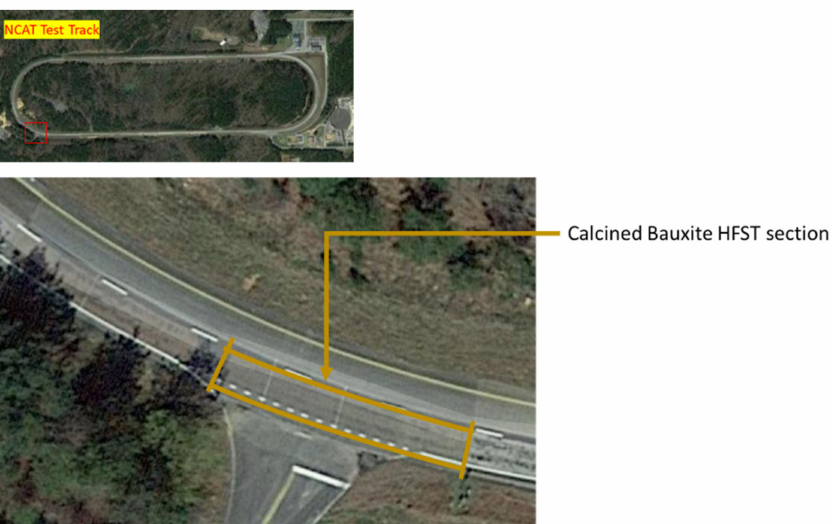
Figure 5. NCAT test track (top) and location of HFST section on the west end of the test track